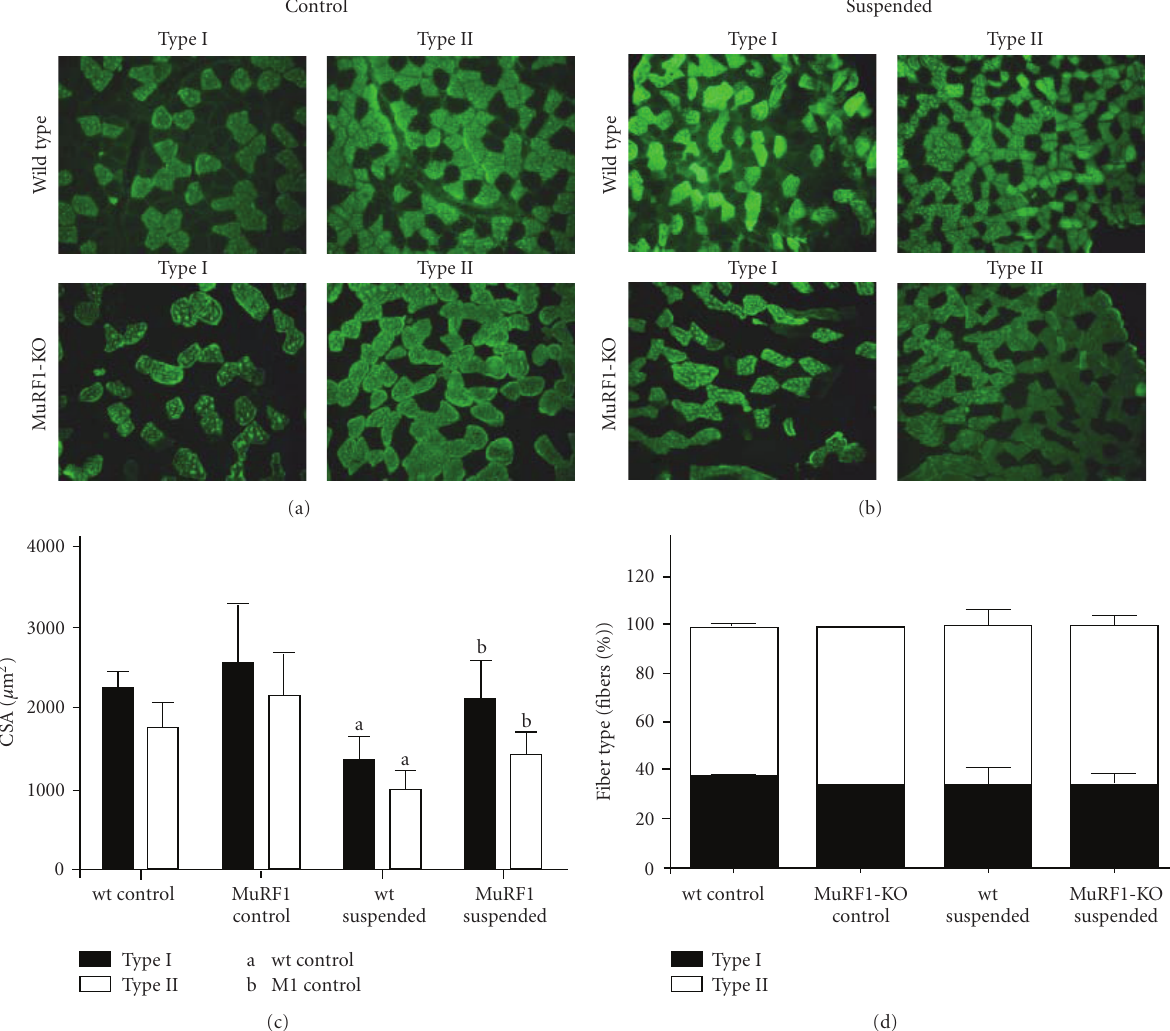
Figure 3: Fiber cross-sectional and fiber type analysis. (a) and (b): examples of cross-sections of soleus muscle stained for type I and type II fibers of wt (top row) and MuRF1-KO (bottom row) of control (left two columns) and suspended (right two columns) mice. (c): cross- sectional area analysis; (d): fiber type